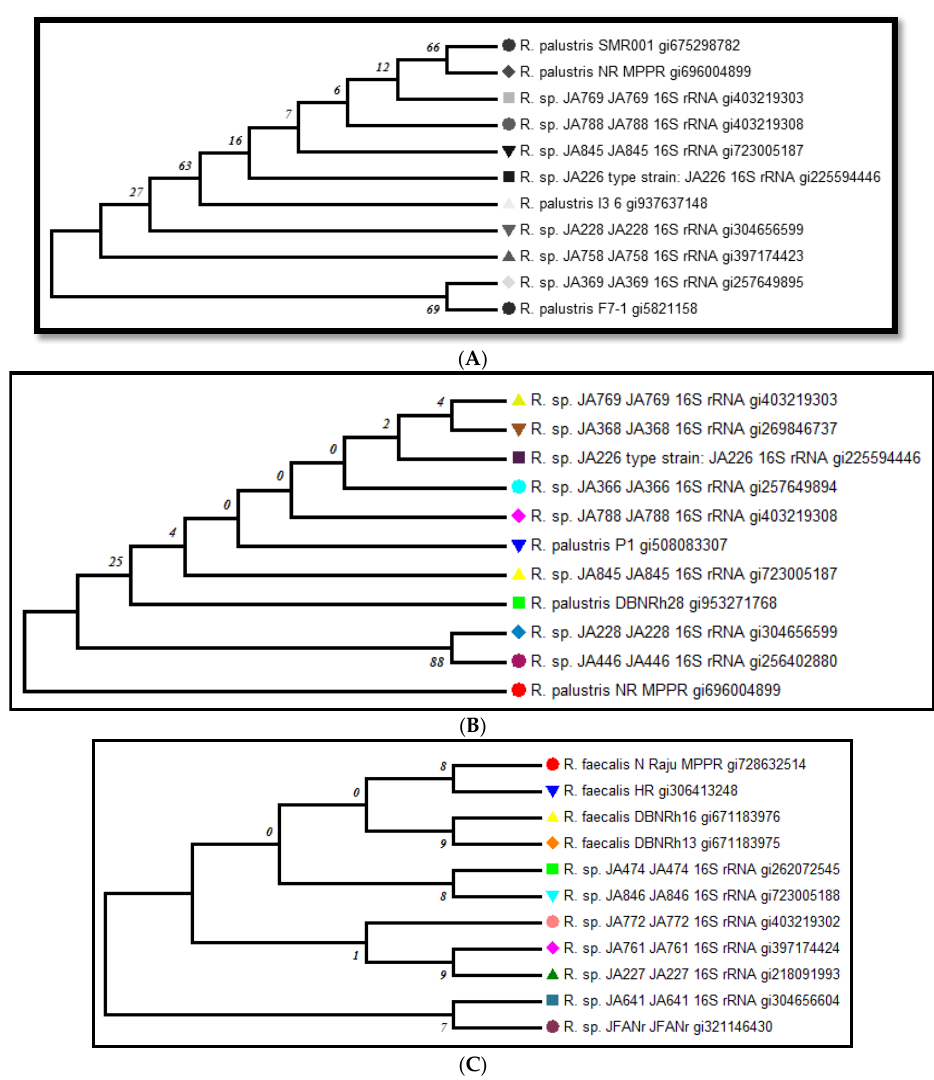
Figure 3. ( A ) Phylogenetic tree (neighbor-joining method) for R. palustris strain SMR001; ( B ) Phylogenetic tree (neighbor-joining method) for R. palustris NR MPPR; ( C ) Phylogenetic tree (neighbor-joining method) for R. faecalis N Raju MPPR.